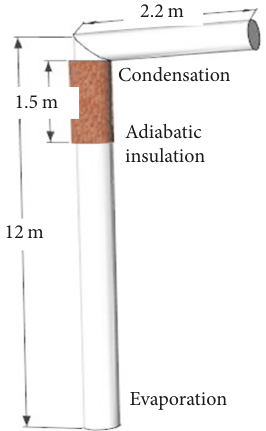
Figure 1: Heat pipe structure diagram.